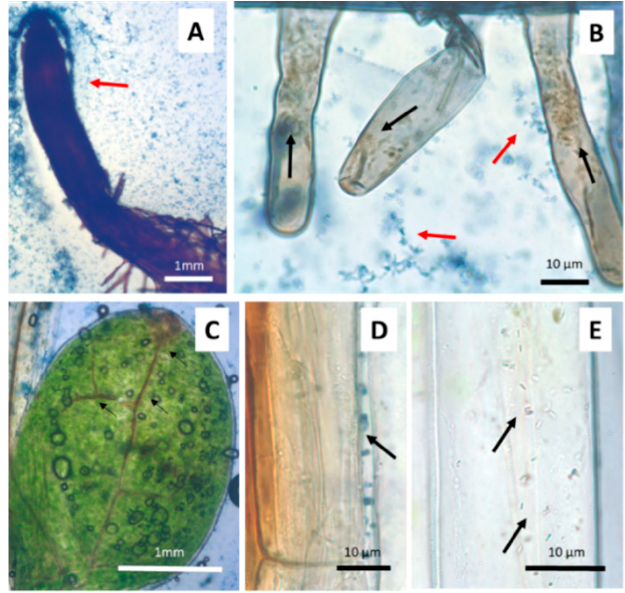
Figure 3 . J. montana seedling plant control. ( A ). Root surrounded by a bacterium commu ‐ nity (red arrow). ( B ). Detail of the matrix that surrounds the root hairs where aniline blue stained bacteria can visualize (red arrow). Brown bacteria stained with DAB/peroxidase for reactive oxygen (black arrows) within lateral hairs. ( C ). Healthy cotyledons without signs of deterioration due to oxidative stress. Defection of H 2 O 2 accumulation in circula ‐ tory system (black arrows). ( D ). Aniline blue coccoidal bacteria in apoplastic space of root (black arrow). ( E ). Bacteria rods stained with aniline blue inside hypocotylous paren ‐ chyma (black arrows).